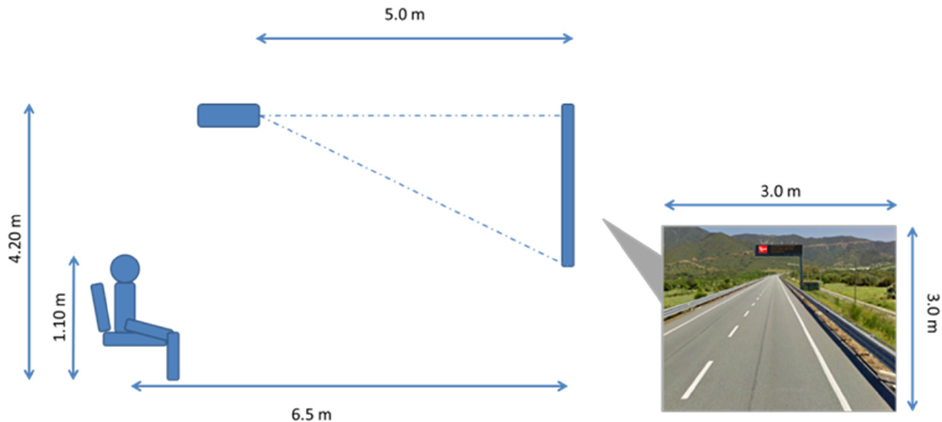
Figure 1. Left: layout of the simulation room. Right: a frame of the broadcasted driving scene. A typical suburban road scene was created using video editing software. The driving scene simulated a vehicle passing along a straight road upon which a VMS is located (Figure 1—right). To test the reading times under different conditions, each driving scene was displayed for 6” at a speed of 50 km/h and for 3” at a speed of 80 km/h. The choice of the two test speeds was linked to the type of road used in the test—that, is a single carriageway with two lanes and two-way traffic, with a speed limit of 80 km/h in force on it. The panel was visible for the whole duration of the video.